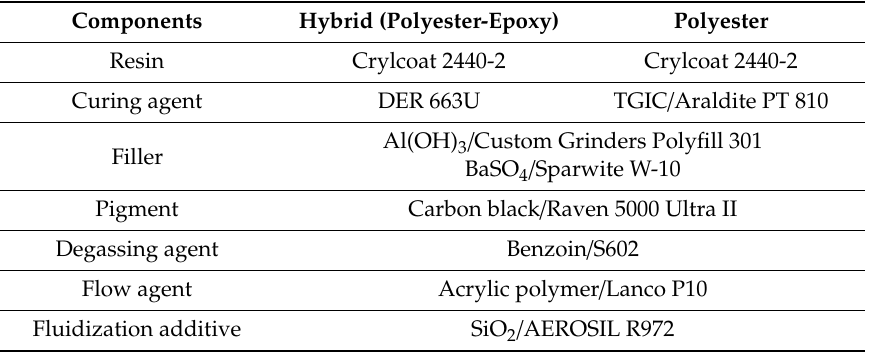
Table 1. Materials.